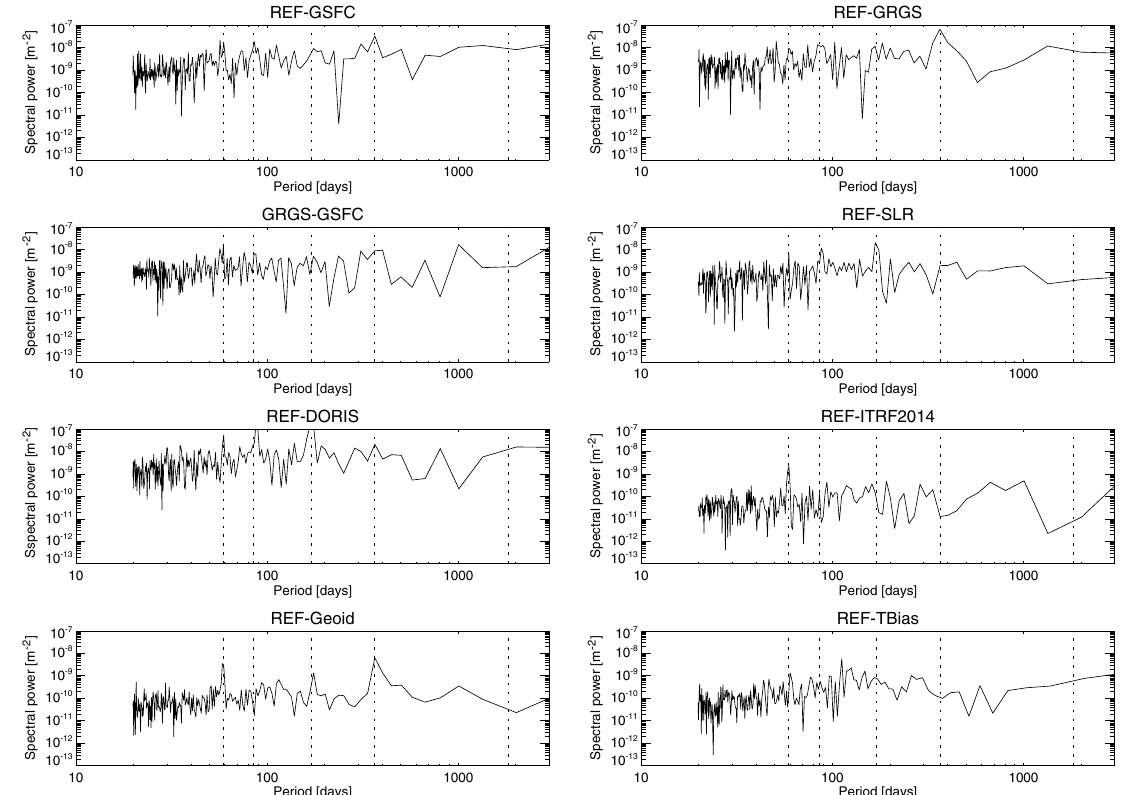
Figure A2. Power spectra of the global mean radial orbit differences over the oceans for REF minus GSFC, REF minus GRGS, GRGS minus GSFC, REF minus SLR, REF minus DORIS, REF minus ITRF14, REF minus Geoid, and REF minus TBias. Vertical dashed lines mark periods of 59, 85, and 170 days, and 1 and 5